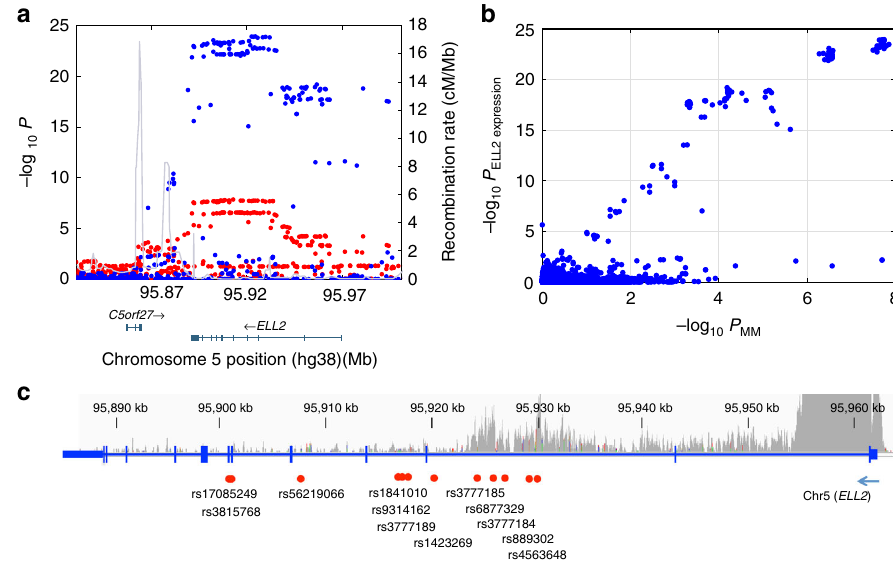
Fig. 2 ELL2 MM risk variants coincide with ELL2 eQTLs. a Regional association plot of the ELL2 locus at chromosome 5q15. Blue dots indicate association with ELL2 expression based on the four sample sets ( − log 10 -transformed Fisher ’ s inverse χ 2 P values; meta-analysis of 158 Swedish-Norwegian and 1445 SNP microarray-genotyped samples from Germany, UK, and US). Red dots indicate association with MM ( − log 10 -transformed logistic regression P values from our previous Swedish-Norwegian-Iceland MM association study). The lead variant for the effect on ELL2 expression is rs9314162. Meiotic recombination rates calculated from the 1000 Genomes compendium indicted by the gray curve. b Two-dimensional plot of the same association P values. The two top-right clusters contained 66 variants in fl uencing both MM risk and ELL2 expression. c Schematic representation of ELL2 . The indicated variants are the lead variants for ELL2 expression (rs9314162), the fi rst reported MM lead variant (rs56219066), the best-supported MM lead variant (rs1423269), the eight variants selected for functional evaluation (rs1841010, rs9314162, rs3777189, rs3777185, rs6877329, rs3777184, rs889302, and rs4563648), and the coding variant rs3815768 used for genotyping in the mRNA-sequencing data. Gray curve indicates ChIP-seq read density for the H3K4me3 histone mark in L363 cells, and main (high peak around exon 1) and internal promoters (lower peaks across introns 1 and